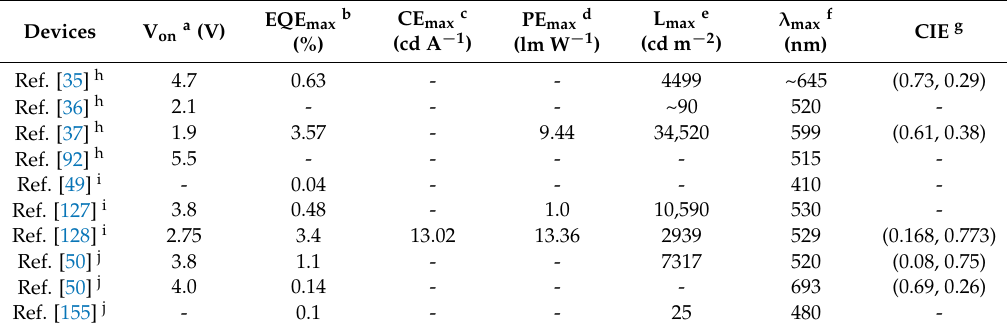
Table 1. Summary of the performances of representative